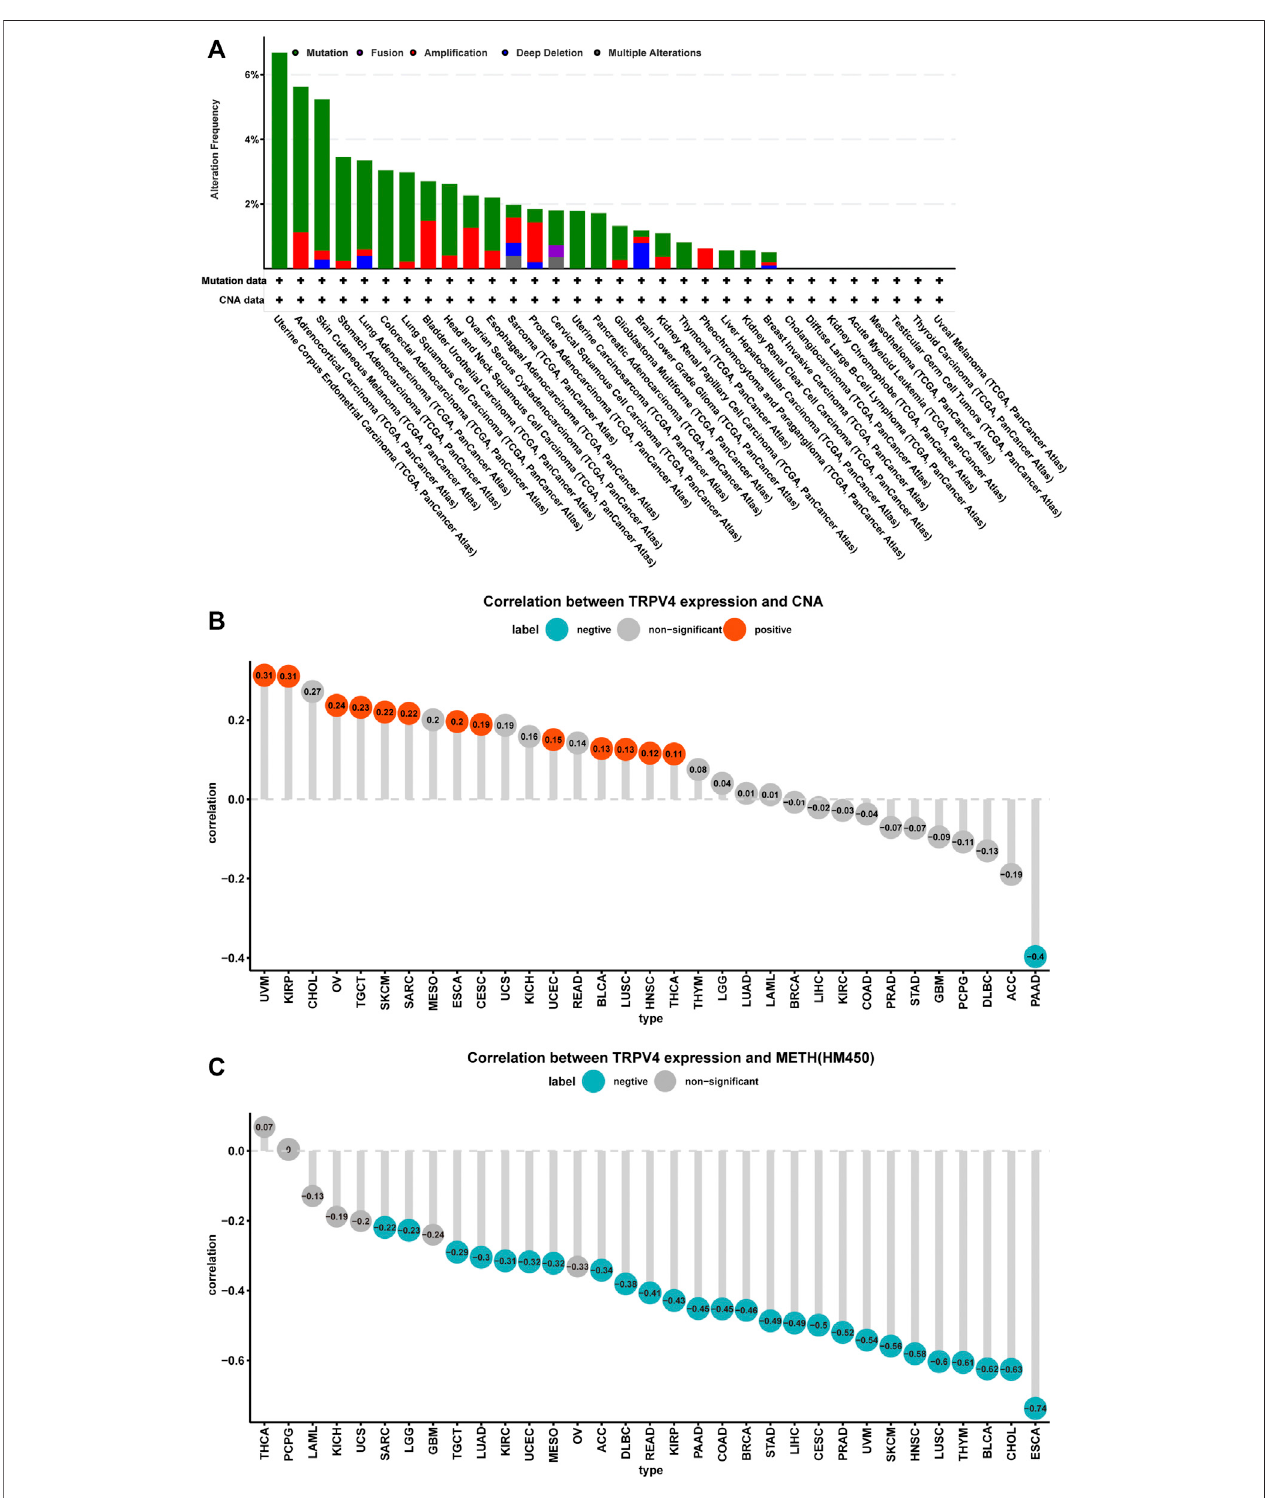
FIGURE 3 | TRPV4 gene alterations in pan-cancer. (A) CNA and mutation status of TRPV4 in TCGA pan-cancer samples. (B) The correlation between TRPV4 expression and linear copy-numbervaluein TCGA pan-cancer samples. (C) Thecorrelationbetween TRPV4 expression and methylation levels of TRPV4 asapromoter in TCGA pan-cancer samples. The pearson ’ s correlation coef fi cient was calculated using R software.